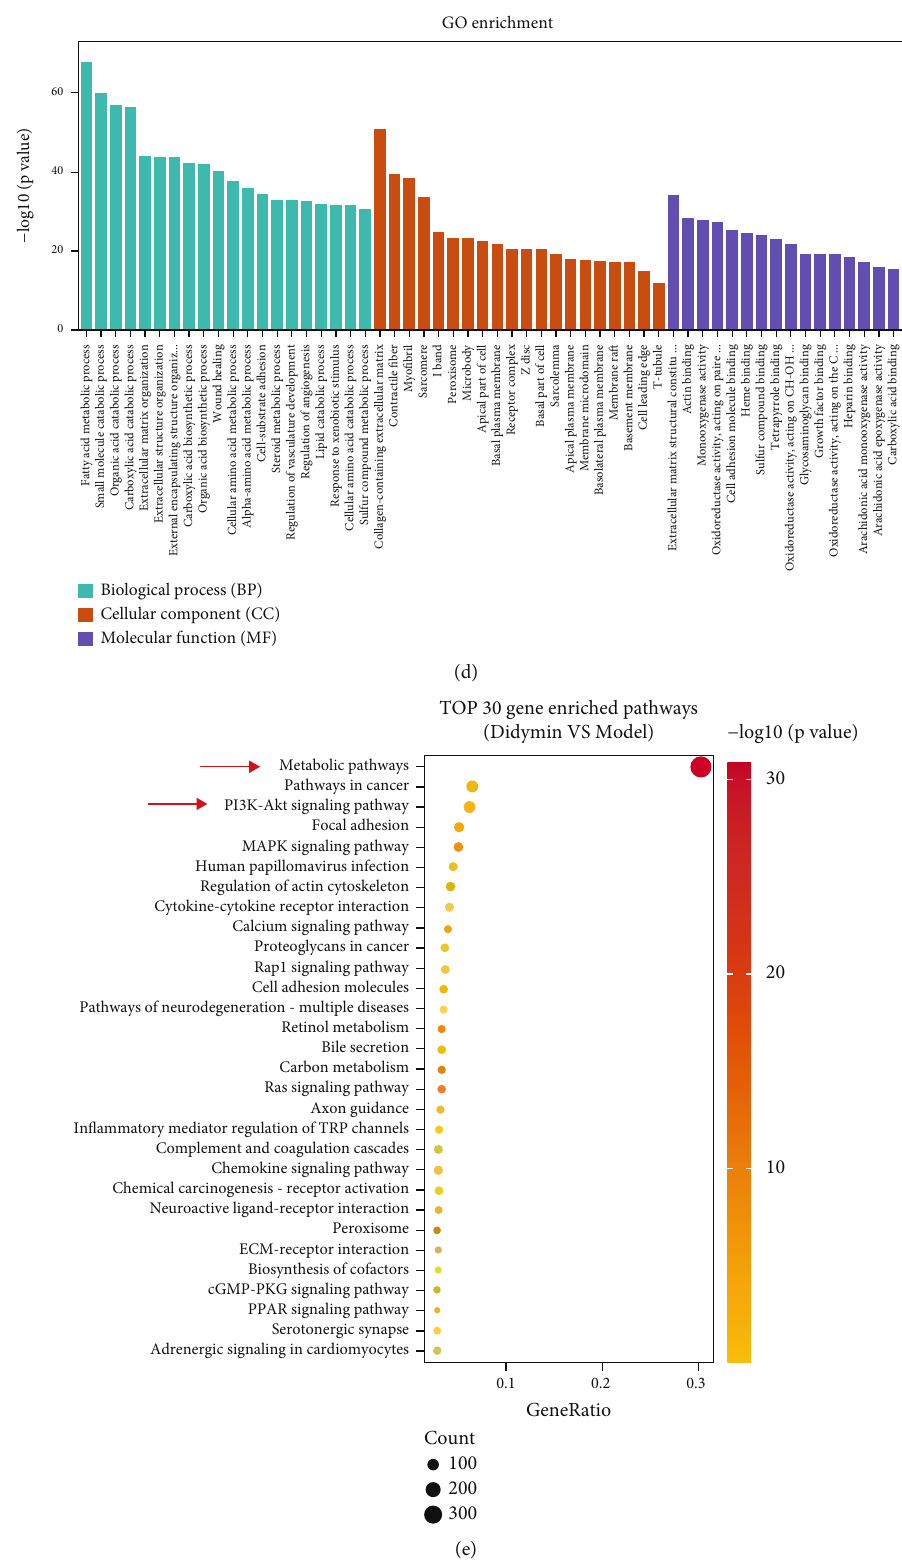
Figure 5: Transcriptomics analysis predicted the potential targets of didymin. (a) The PCA scores plot of normal control, model, and didymin group; the x -axis represents the PC1, and the y -axis represents PC2. (b) The heat map of DEGs. (c) The volcano plot. (d) The enriched GO analysis for the biological process (BP), cellular component (CC), and molecular function (MF). (e) The KEGG enriched pathways